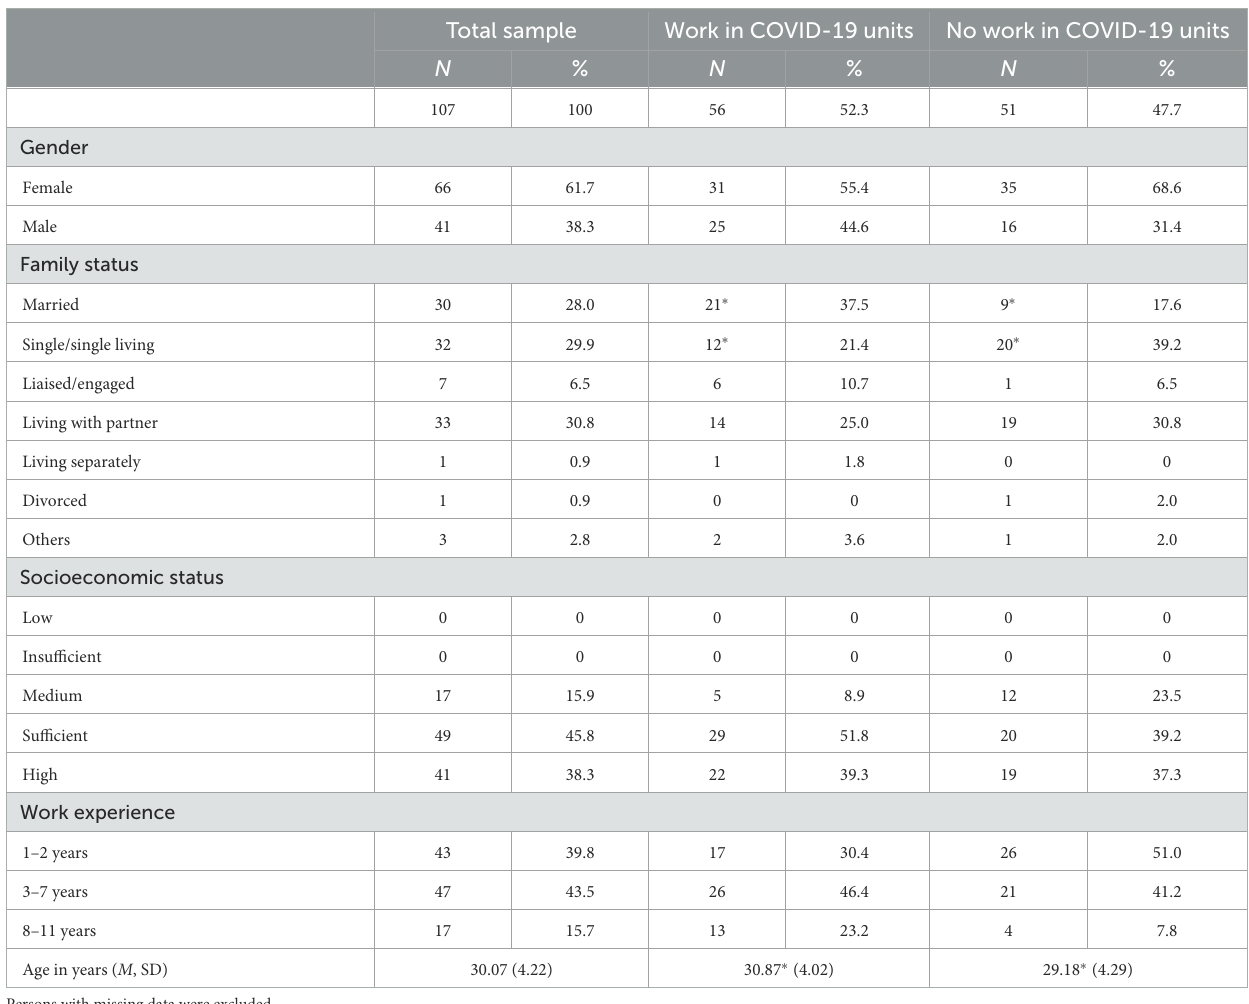
TABLE 1 Sociodemographics and COVID-19 situation. Total sample Work in COVID-19 units